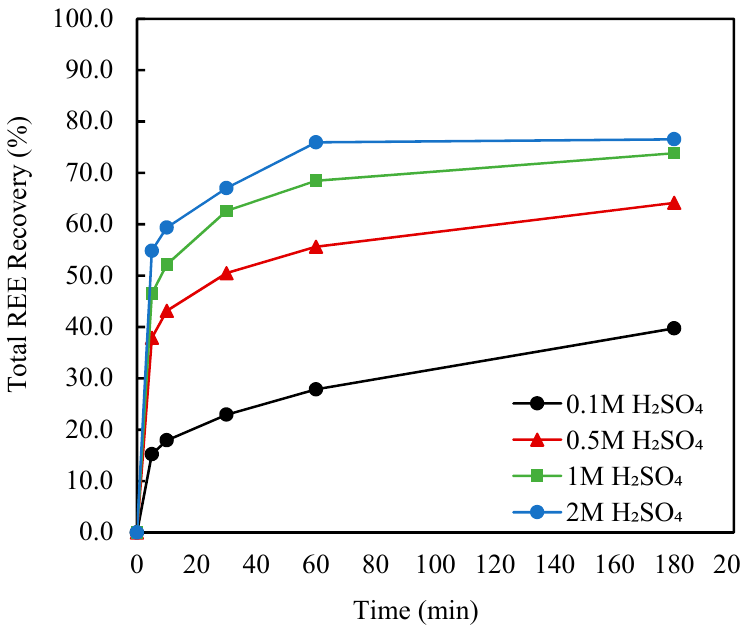
Figure 8. Effect of sulfuric acid solution concentration on the leaching recovery of total rare earth elements contained in the Fire Clay coal middlings (75 °C , 530 rpm, S/L = 10g/L, D 80 = 8.7 μ m).